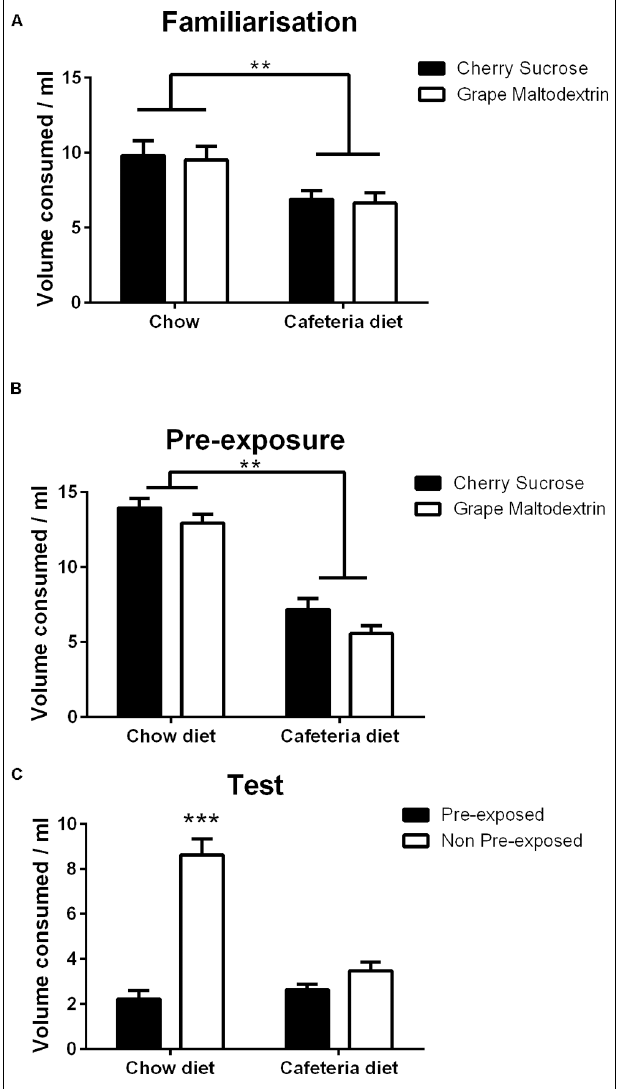
FIGURE 4 | Consumption of sample solutions during (A) Familiarization to the two solutions, (B) Pre-exposure to the solutions prior to test, (C) Sensory-specific satiety test indicating the mean volume consumed of the pre-exposed and non-pre-exposed solutions during two bottle choice testing by chow ( N = 16) and cafeteria ( N = 16) diet fed rats. Data presented as mean ( ± SEM). ** p < 0.01, *** p < 0.001. Bonferroni